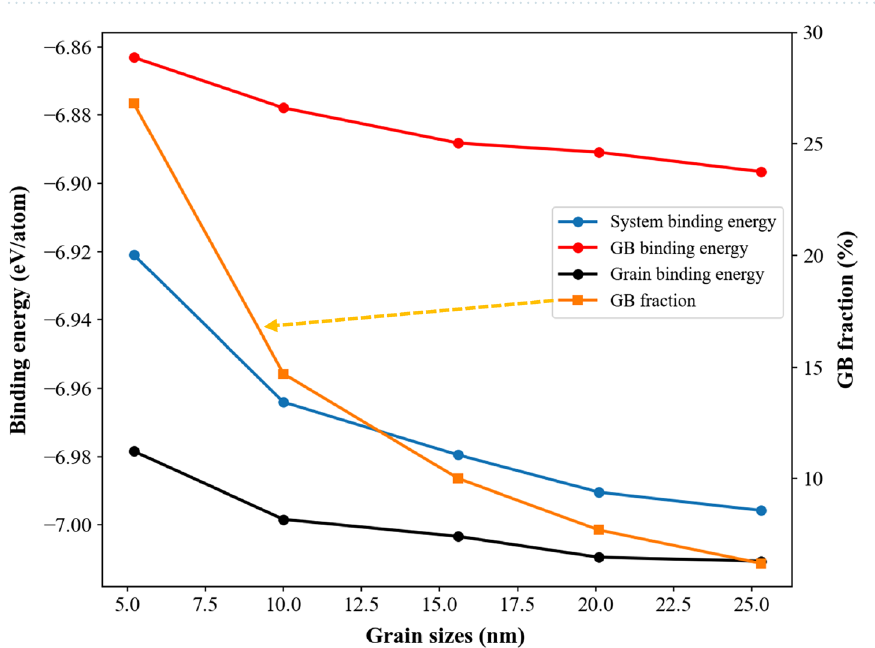
Figure 2. Profiles of GB fraction and the binding energies of grain, GB, and system for Nb 20.6 Mo 21.7 Ta 15.6 W 21.1 V 21.0 RHEAs with the average grain size from 5.2 to 25.3